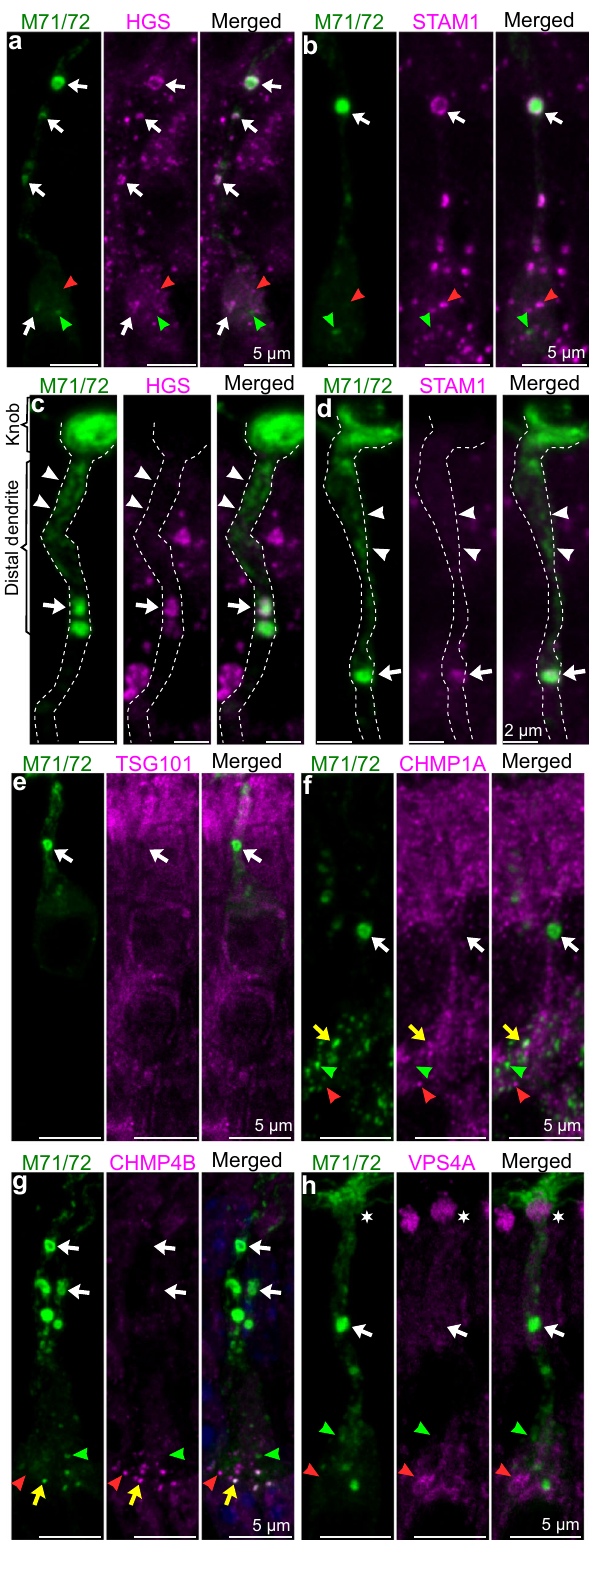
side was without a signi fi cant effect on MVT accumulation. The per- centage of unstimulated OSNs that lacked MVTs and expressed RP2 in thedistaldendriticplasmamembranewasunalteredbynarisocclusion (the yellow arrow and sectors of the pie charts in Fig. 7d´ and e, respectively). All OSNs that were intensely positive for S100A5 lacked